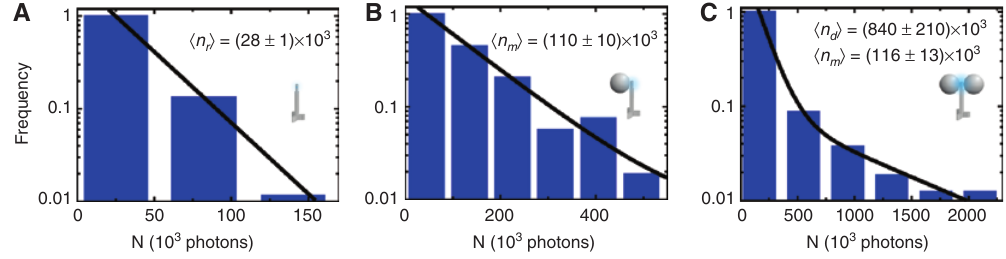
Figure 2: Experimental total number of photons. Normalized semi-log histogram plot of the total number of photons for samples A, B, and C in (A), (B) and (C), respectively. The black line shows a fit using an exponential distribution (samples A and B) and a bi-exponential distribution (sample